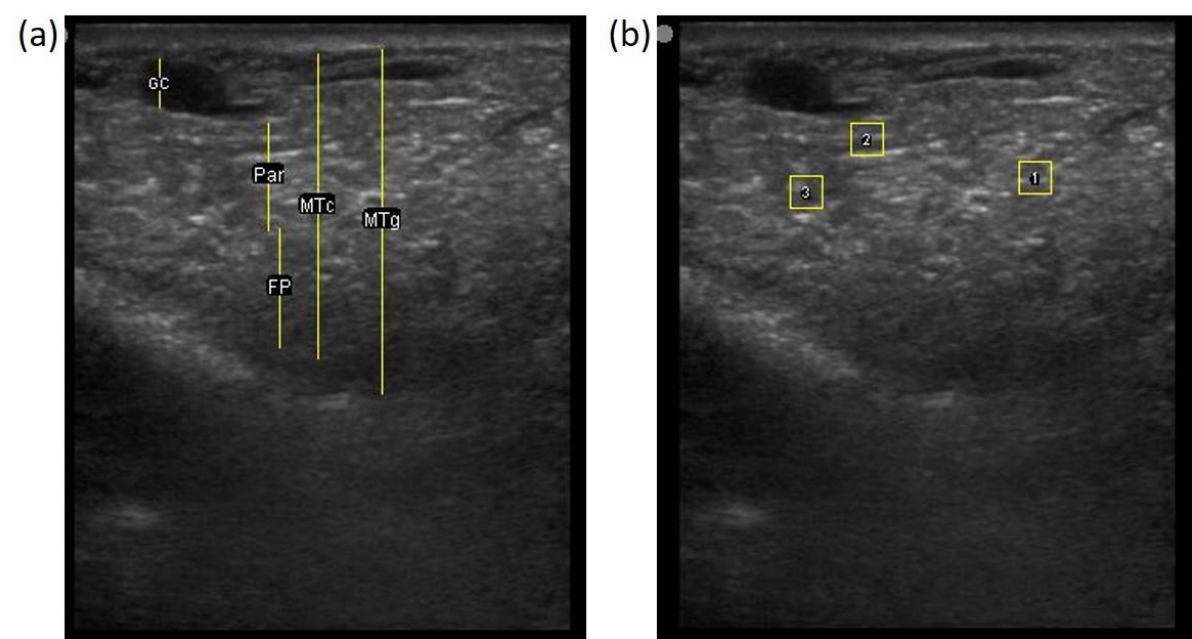
Figure 5. ( a ) Demonstration of delimitations of the mammary total depth conservative (MTc) and generous (MTg), mammary gland cistern (GC), parenchyma (PAR) and the fat pad (FP) and ( b ) Demonstration of randomly positioning of regions of interest (1, 2, 3) in the parenchyma.